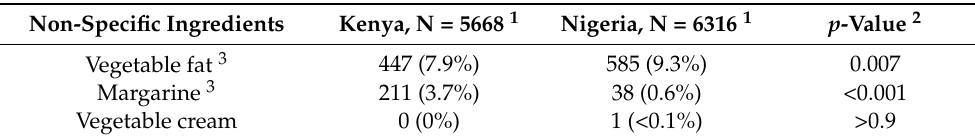
Table A1. Number and proportion of products containing each non-specific ingredient that may be indicative of